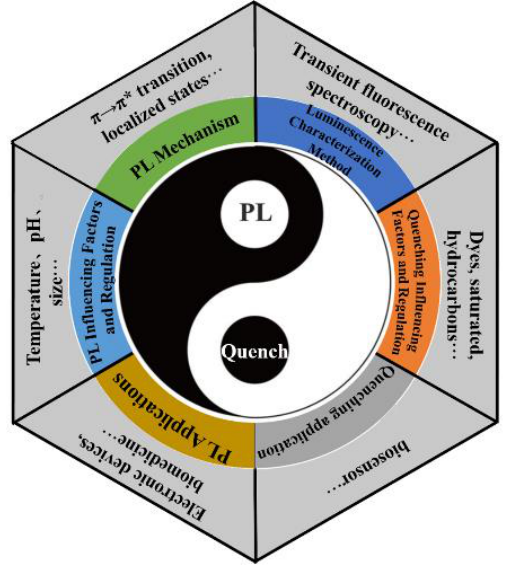
Figure 1. Research content of this review.